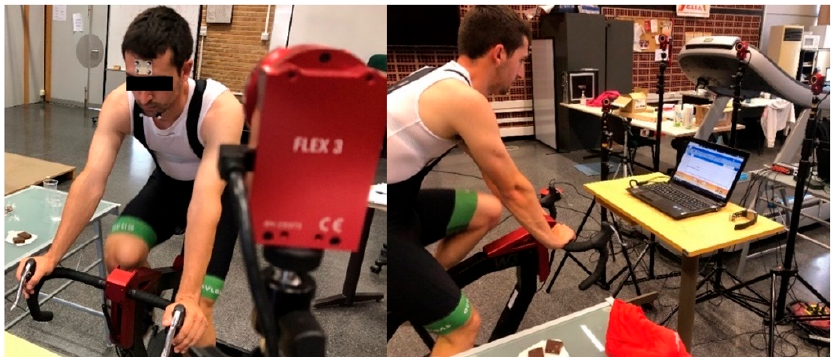
Figure 2. Cyclist with markers placed on his jaw and forehead during the test.